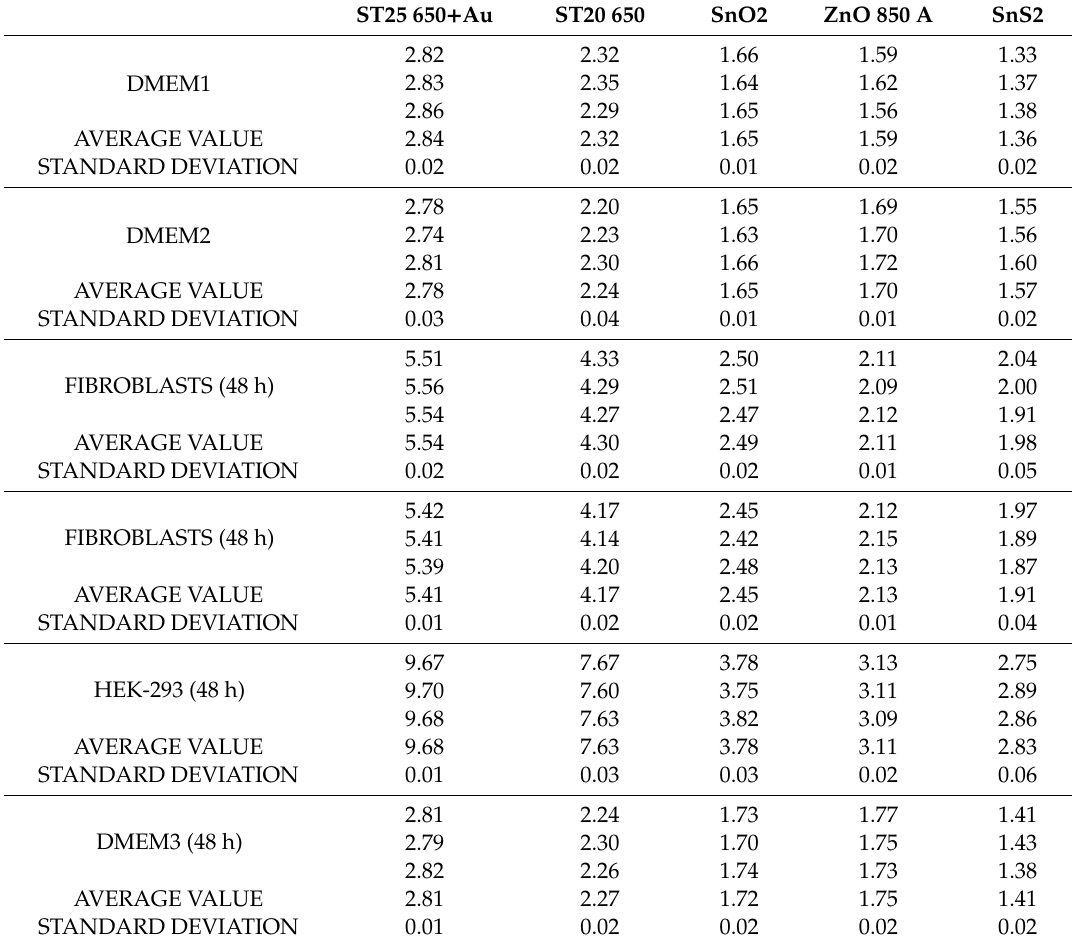
Table 3. Data, average values, and standard deviations from cell cultures tests shown in Figure